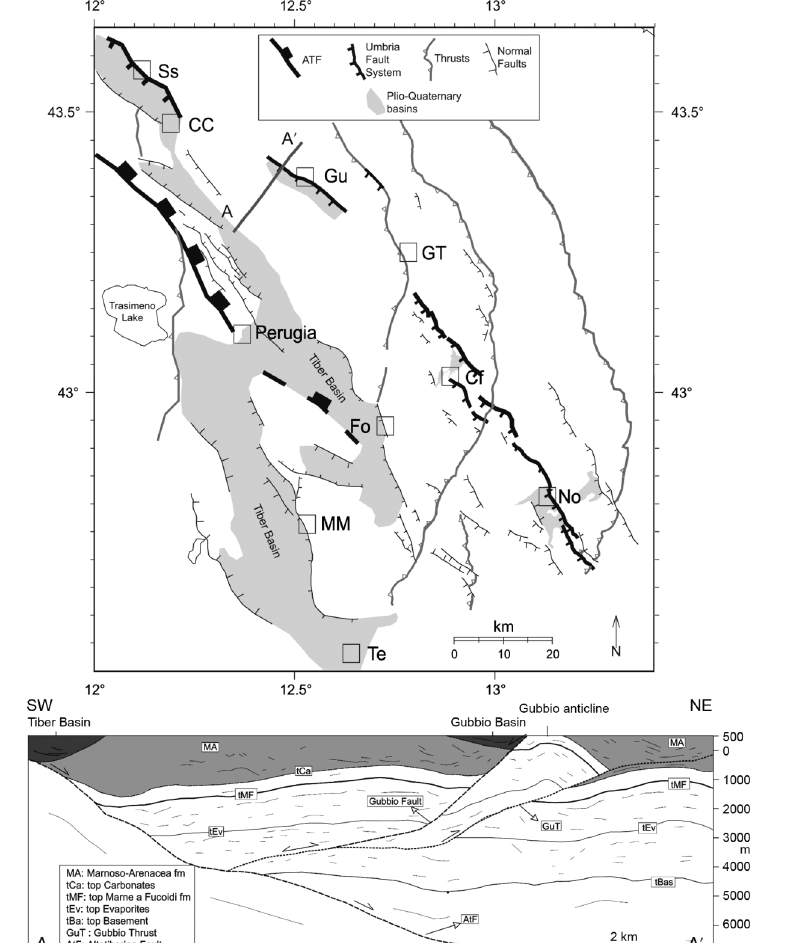
Fig. 2. Schematic structural map of the Umbrian region (modified after Barchi, 2002). The seismic reflection profile (A-A l ) showing the AtF and the antithetic Gubbio Fault is from Mirabella et al.